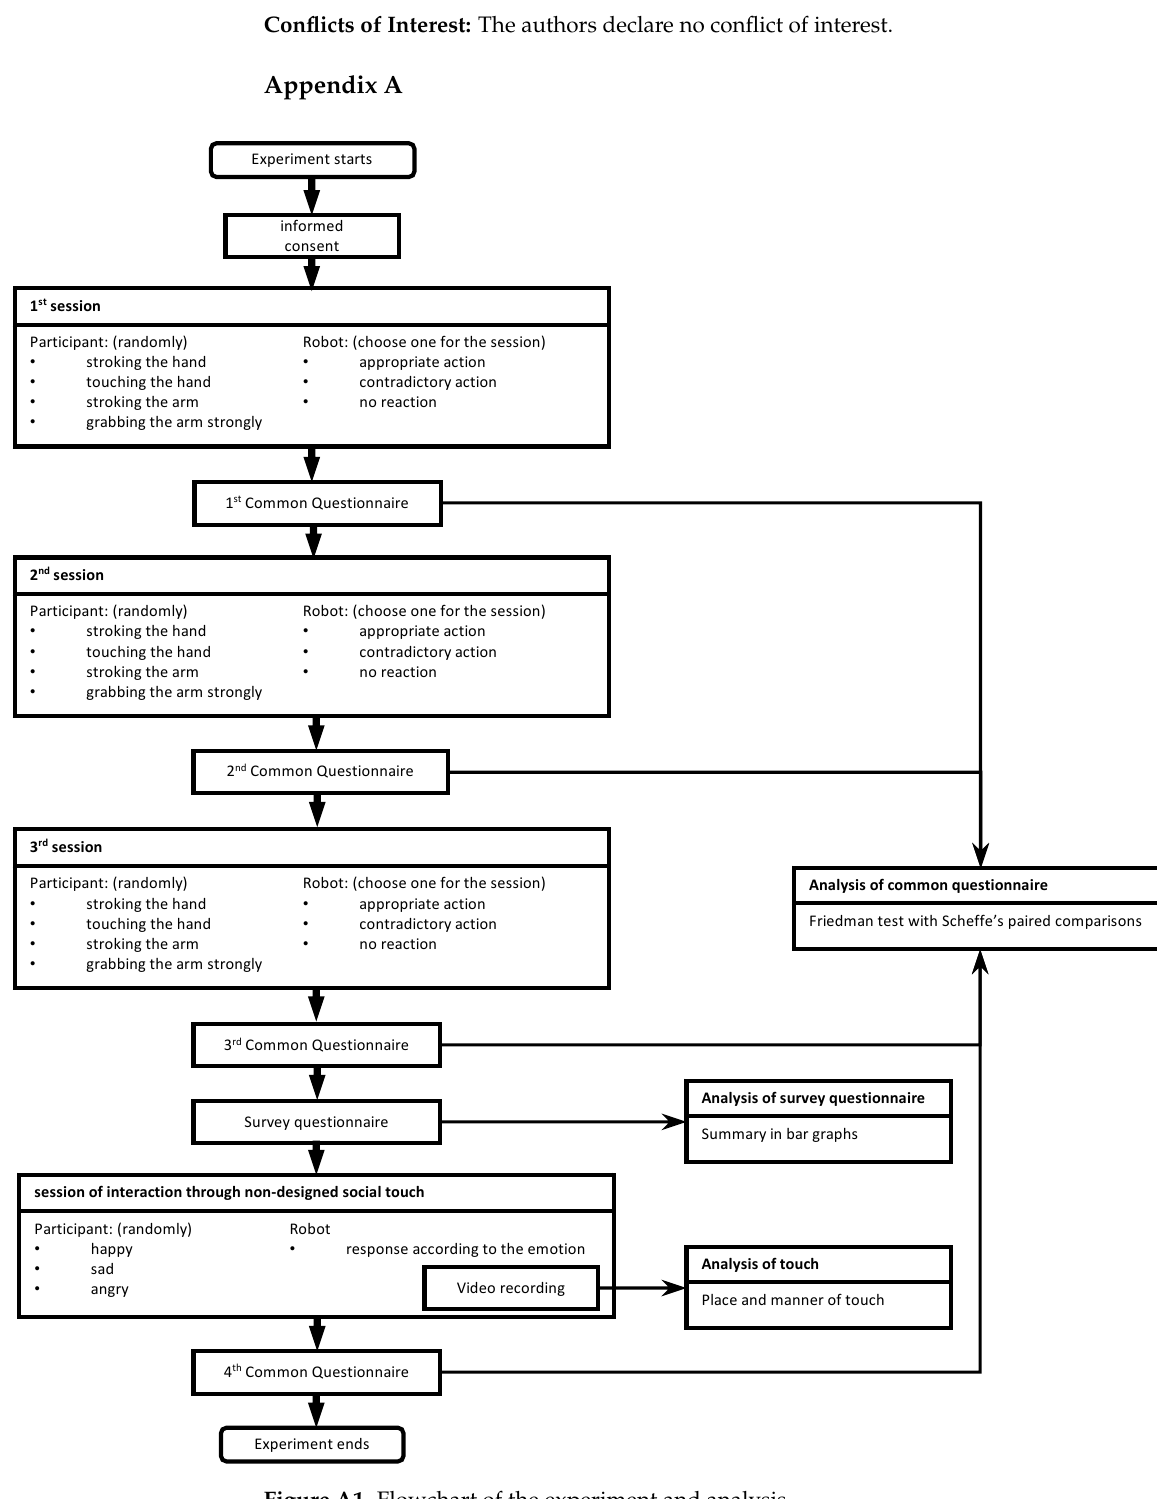
Figure A1. Flowchart of the experiment and